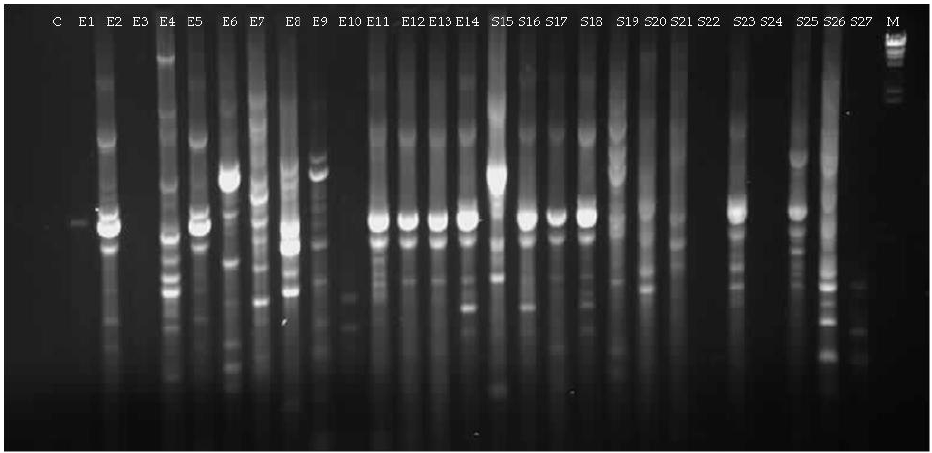
Figure A3. BOX-PCR profiles of isolated obtained from Elpida and Silverio seeds, were checked by electrophoresis in 1.5% agarose gels stained with ethidium bromide that included a marker Lambda/ Hind III.